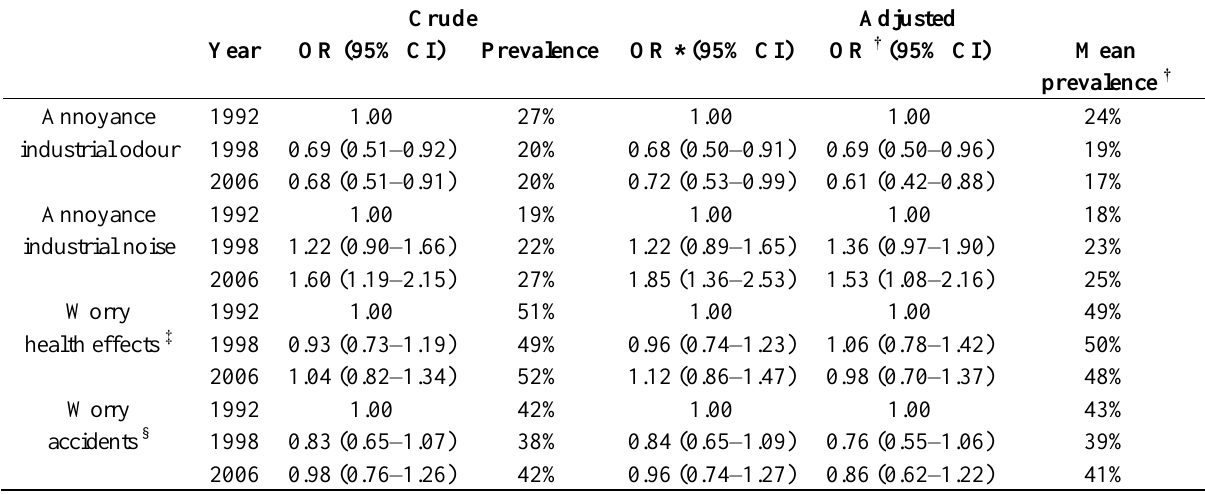
Table 2. Annoyance and worries about aspects of industrial activity over time in the exposed